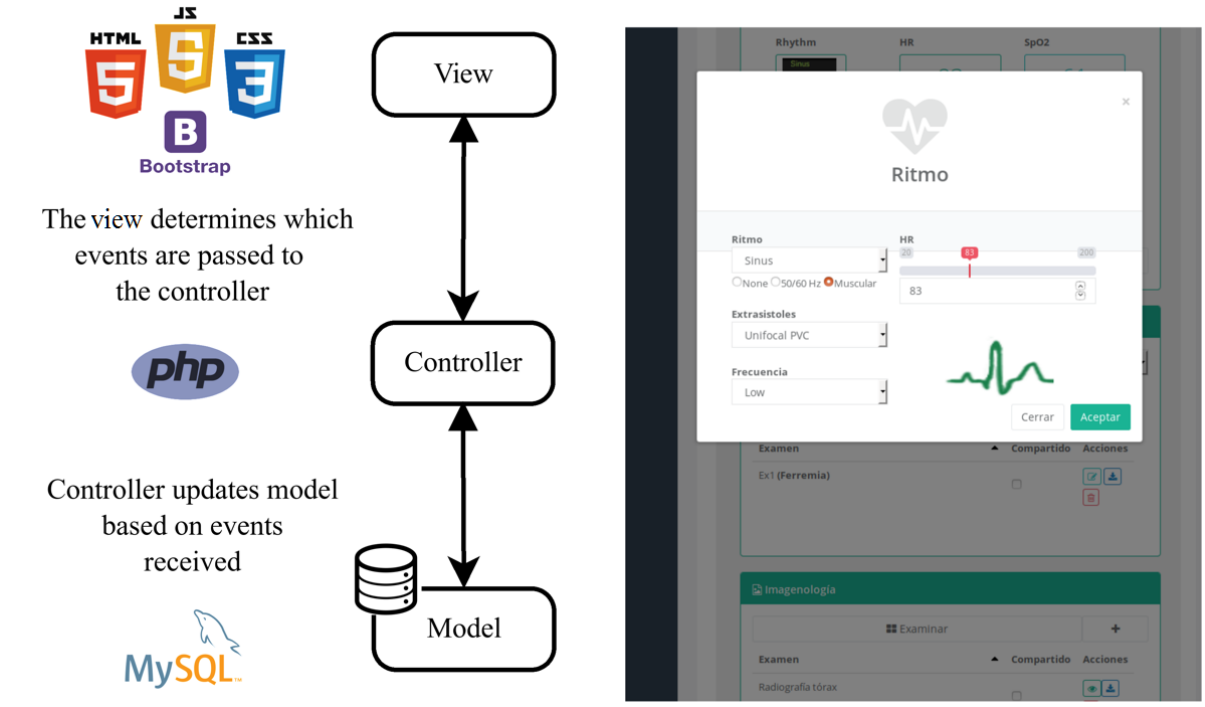
Figure 2. The software architecture and technologies implemented. The platform applies the Model-View-Controller architectural pattern. Controllers manage all requests from the view layer and update the model based on events or data received. The view layer renders the data sent from the model layer through a controller, and the web-based responsive interface uses technologies on a wide variety of devices, such as smartphones, tablets, or desktop computers. CSS: Cascading Style Sheets; JS: JavaScript; PHP: Hypertext Preprocessor; SQL: Structured Query